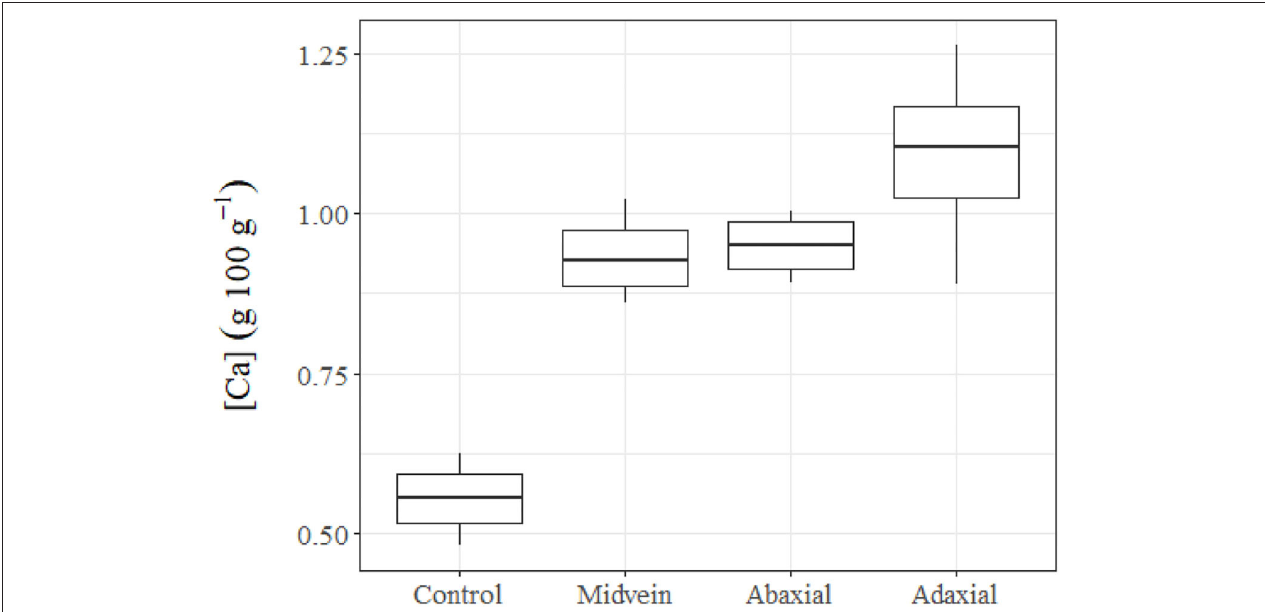
FIGURE 6 | Tissue Ca concentrations of untreated (control) holly leaves compared with leaves treated with 150mM CaCl 2 via the mid vein, or the adaxial or abaxial leaf side. Holly leaves were sampled 24h after foliar Ca application.